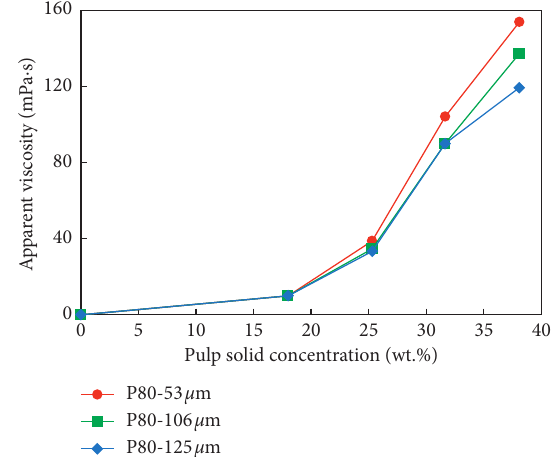
Figure 4: Apparent viscosity of the ore as a function of pulp density for different P80 values (after